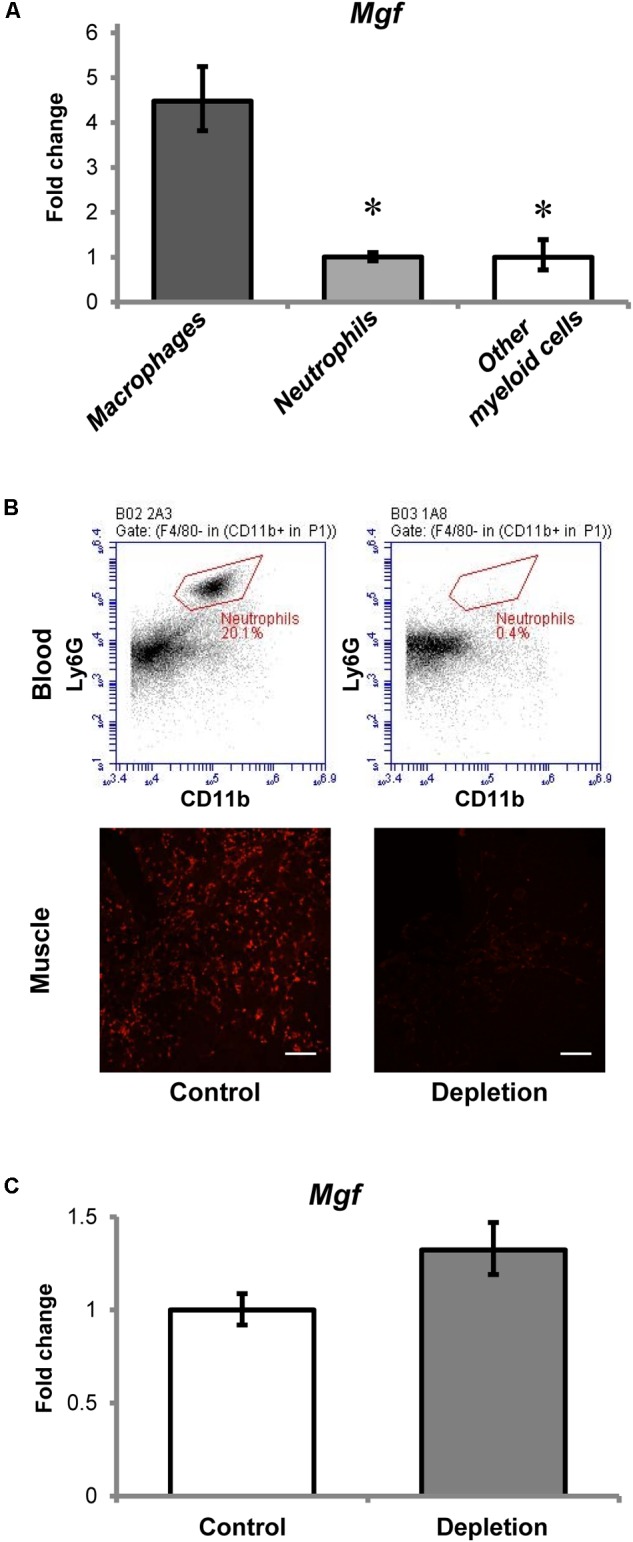
Contribution of myeloid cells to MGF upregulation in muscle injury. (A) Expression of Mgf in myeloid cells isolated from muscles at 36 h post-injury (n = 4–6/myeloid cell type). Gapdh expression served as the internal control. The expression level is relative to that of other myeloid cells. Significant differences from macrophages: ∗P < 0.05. Statistics were analyzed by one-way ANOVA and followed by Bonferroni test. Values represent mean ± SEM. (B) Effect of anti-Ly6G antibody administration on circulating neutrophils and neutrophil infiltration into CTX-injured muscle at 1 day post-injury. This is compared with control treated with isotype control antibody. The upper panel demonstrates the flow cytometric analysis of neutrophils (CD11b+ F4/80- Ly6G+ cells) in blood, while the lower panel indicates the Ly6G immunopositive staining (red) representing neutrophils in muscle injury. Scale = 100 μm. (C) Expression of Mgf in neutrophil-depleted CTX-injured muscles at 1 day post-injury (n = 7/treatment). Gapdh expression served as the internal control. This is compared with control treated with isotype control antibody. Values represent mean ± SEM.